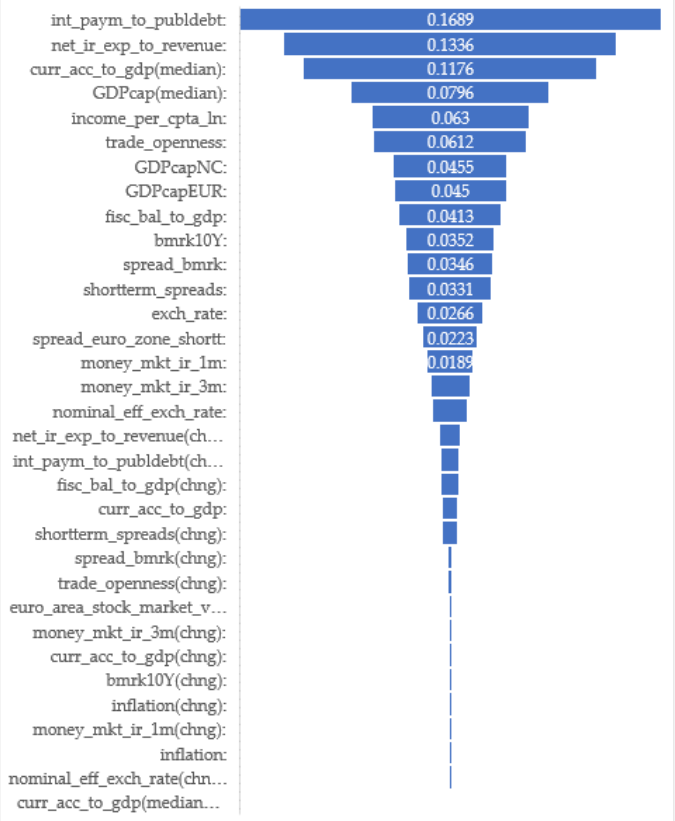
Figure 2. Random Forest Regression ver. 2.0 — Parametric assessment of the factor influence of all indicators on the government debt-to-GDP ratio. Source: Authors’ calculations.